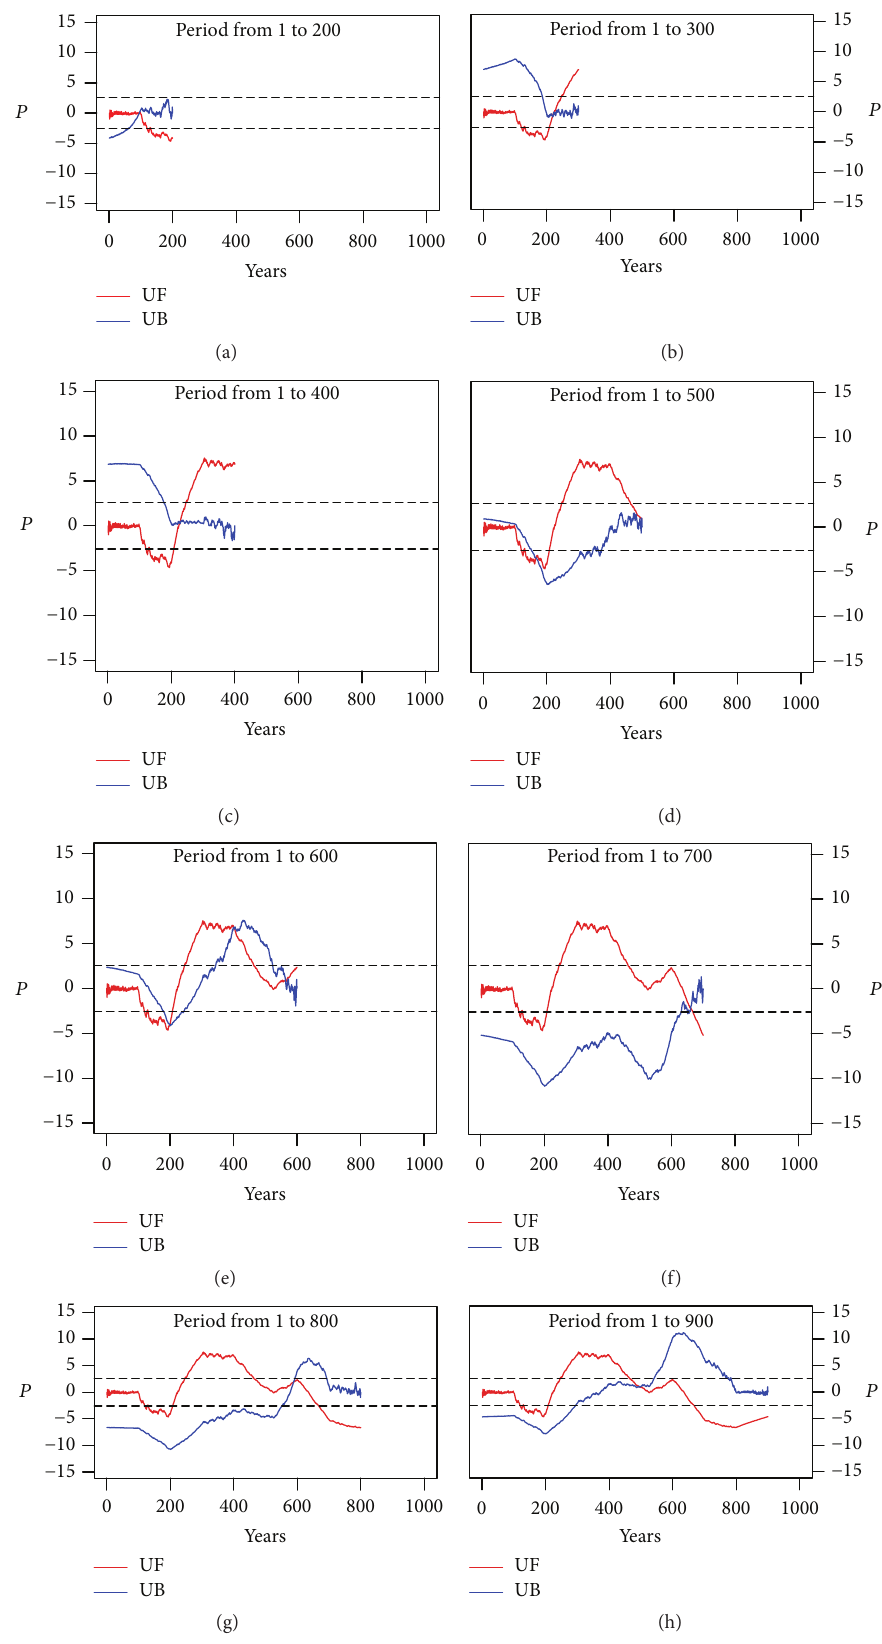
Figure 10: Effects of different study periods on the MK